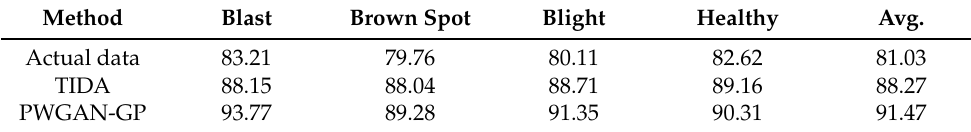
Table 10. Impact of data augmentation on the accuracy of the VGG-16 model (%).